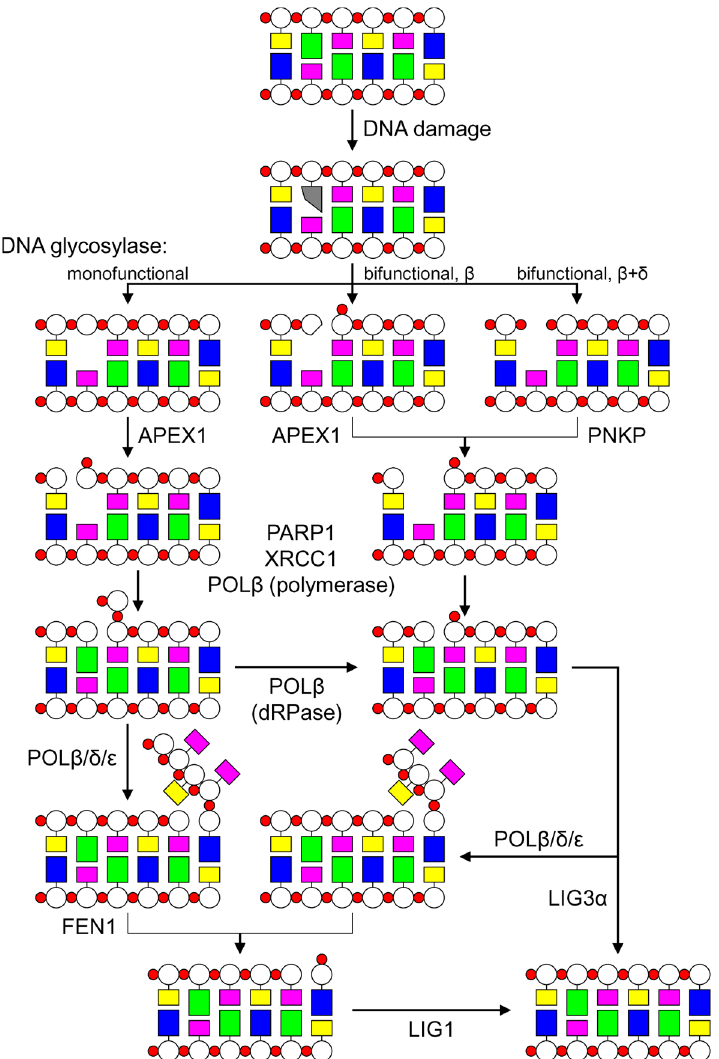
Figure 6. Principal scheme of base excision repair in human cells. Colored rectangles represent nucleobases; white circles, 2 ′ -deoxyribose; red circles, internucleoside phosphate groups. After DNA damage, the damaged base is excised by a DNA glycosylase. Depending on the nature of the product of this reaction, the 3 ′ end is cleaned by APEX or PNKP. Extension by POL β can be channeled into either a short-patch (POL β → LIG3 α ) or long-patch (POL β / δ / ε → FEN1 → LIG1) subpathway.